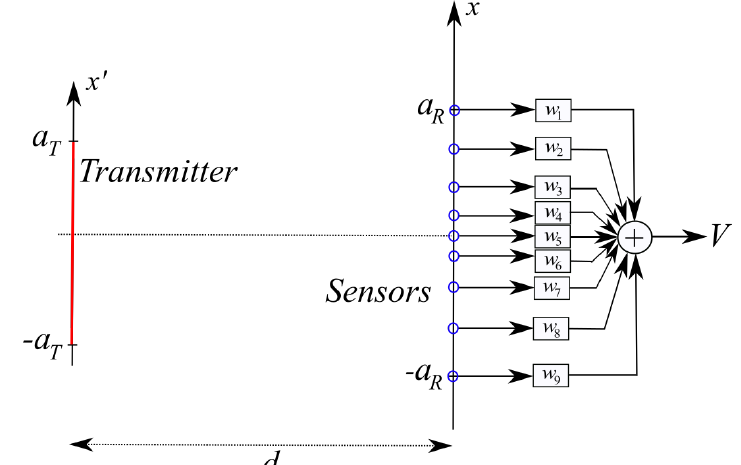
Figure 6. Illustrating the point-like elements array geometry with